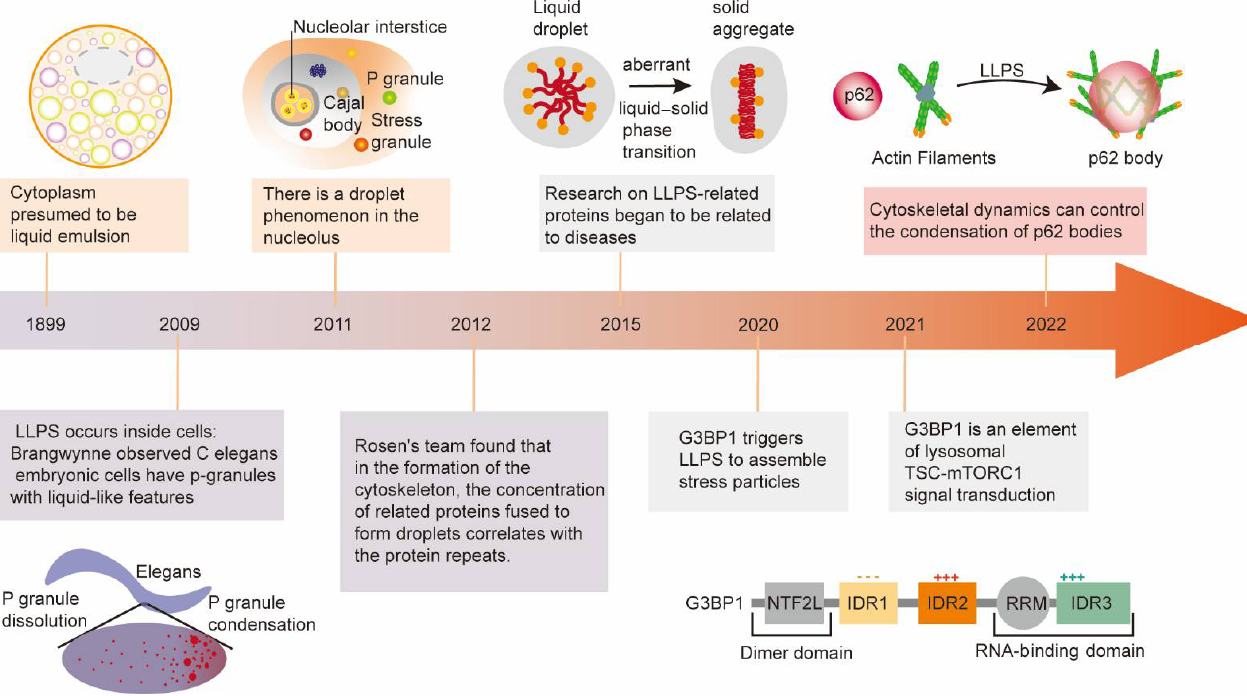
Figure 1. The development history and discovery of the amazing and vital roles of LLPS in biology. Representative milestones sparking tremendous development of LLPS are enumerated in the figure. As early as 1899, Wilson first proposed the existence of droplets in cells [9]. He found that different fluids inside the cells could form suspended emulsion droplets according to the observation of sea urchin eggs. Although his view was largely unrecognized at the